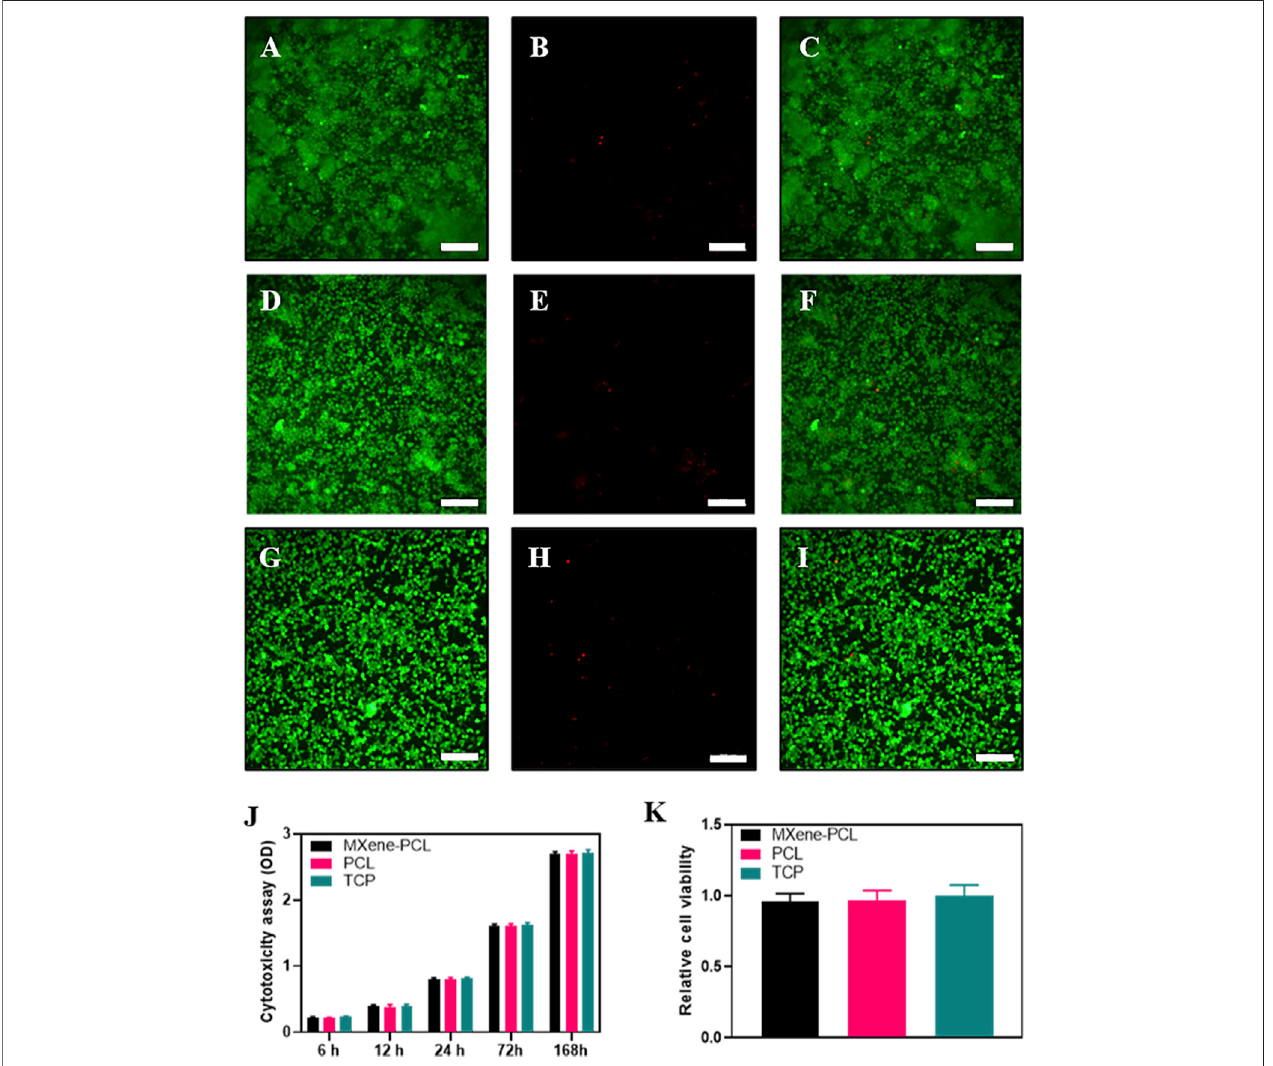
FIGURE 3 | Biocompatibility assessments. LIVE/DEAD cell staining on MXene-PCL scaffolds (A – C) , PCL scaffolds (D – F) and TCP (G – I) . Live cells (green fl uorescence, (A,D,G) . Dead cells (red fl uorescence, (B,E,H) . Merged images (C,F,I) . Cytotoxicity was monitored by CCK-8 assay for RSCs cultured on MXene-PCL scaffolds, PCL scaffolds, and TCP at 6, 12, 24, 72, and 168 h J). Relative cell viability was evaluated by the LIVE/DEAD cell staining for MXene-PCL scaffolds, PCL scaffolds and TCP (H) . Experiments were repeated three times. The scale bar is 200 μ m.